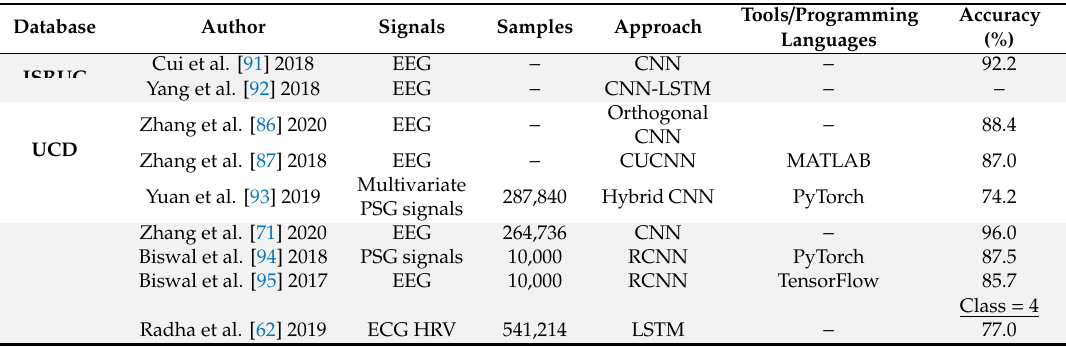
Table 5. Summary of automated sleep stage classification approaches with DL applied to PSG recordings in ISRUC, Massachusetts General Hospital (MGH), and University College Dublin Sleep Apnea Database (UCD) datasets.